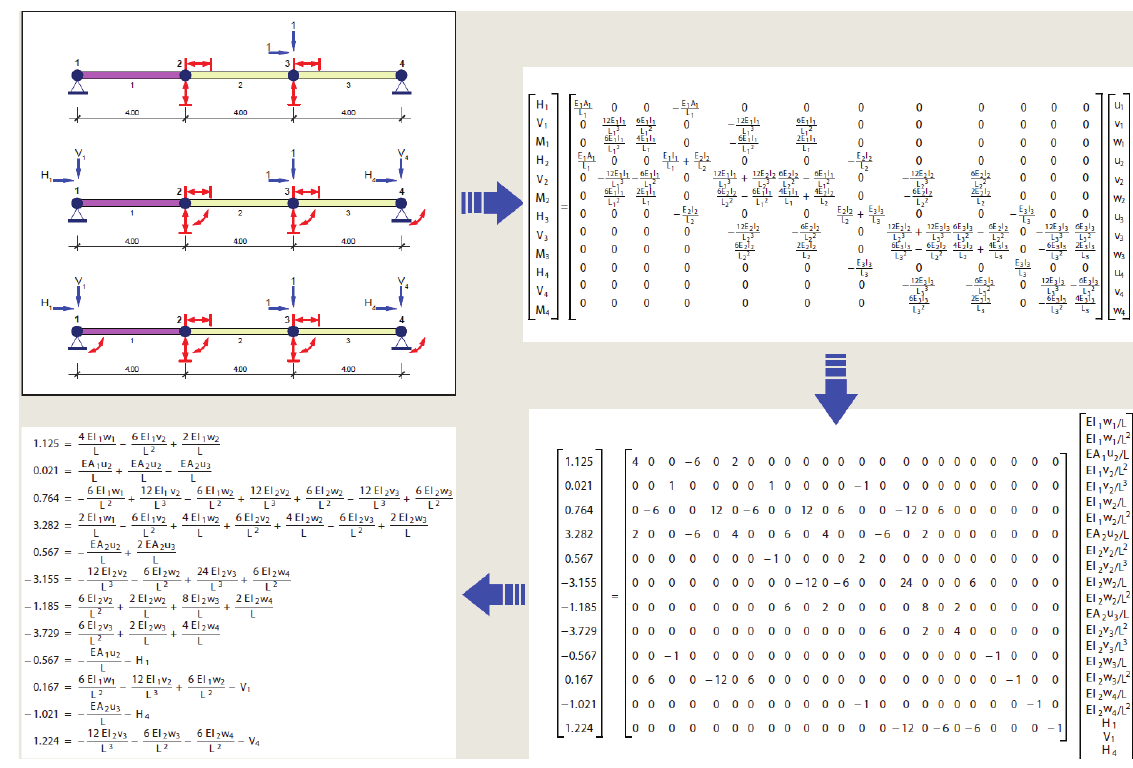
Fig. 2. Example of a simple beam showing the initially measured displacements and forces and the resulting observed extra displacements and forces (reactions) after recursive steps 1 and 2 (a); the resulting stiffness matrix [ K ] and force { f } and displacement {δ} vectors (b); the modified stiffness matrix K * and the monomial products located in the column matrix of the left hand side (c); the system of multivariate polyrational (polynomial) function, which in this case degenerates to a multivariate polynomial system of equations